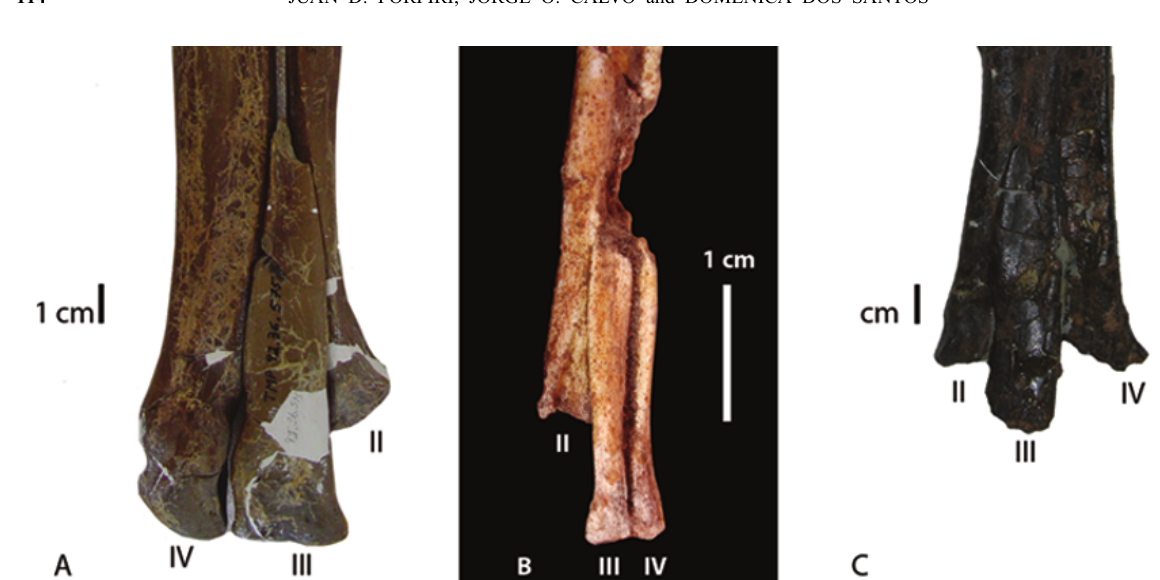
Fig. 6 – Distal end of metatarsals; A: Troodon ; B: Pamparaptor ; C: Neuquenraptor